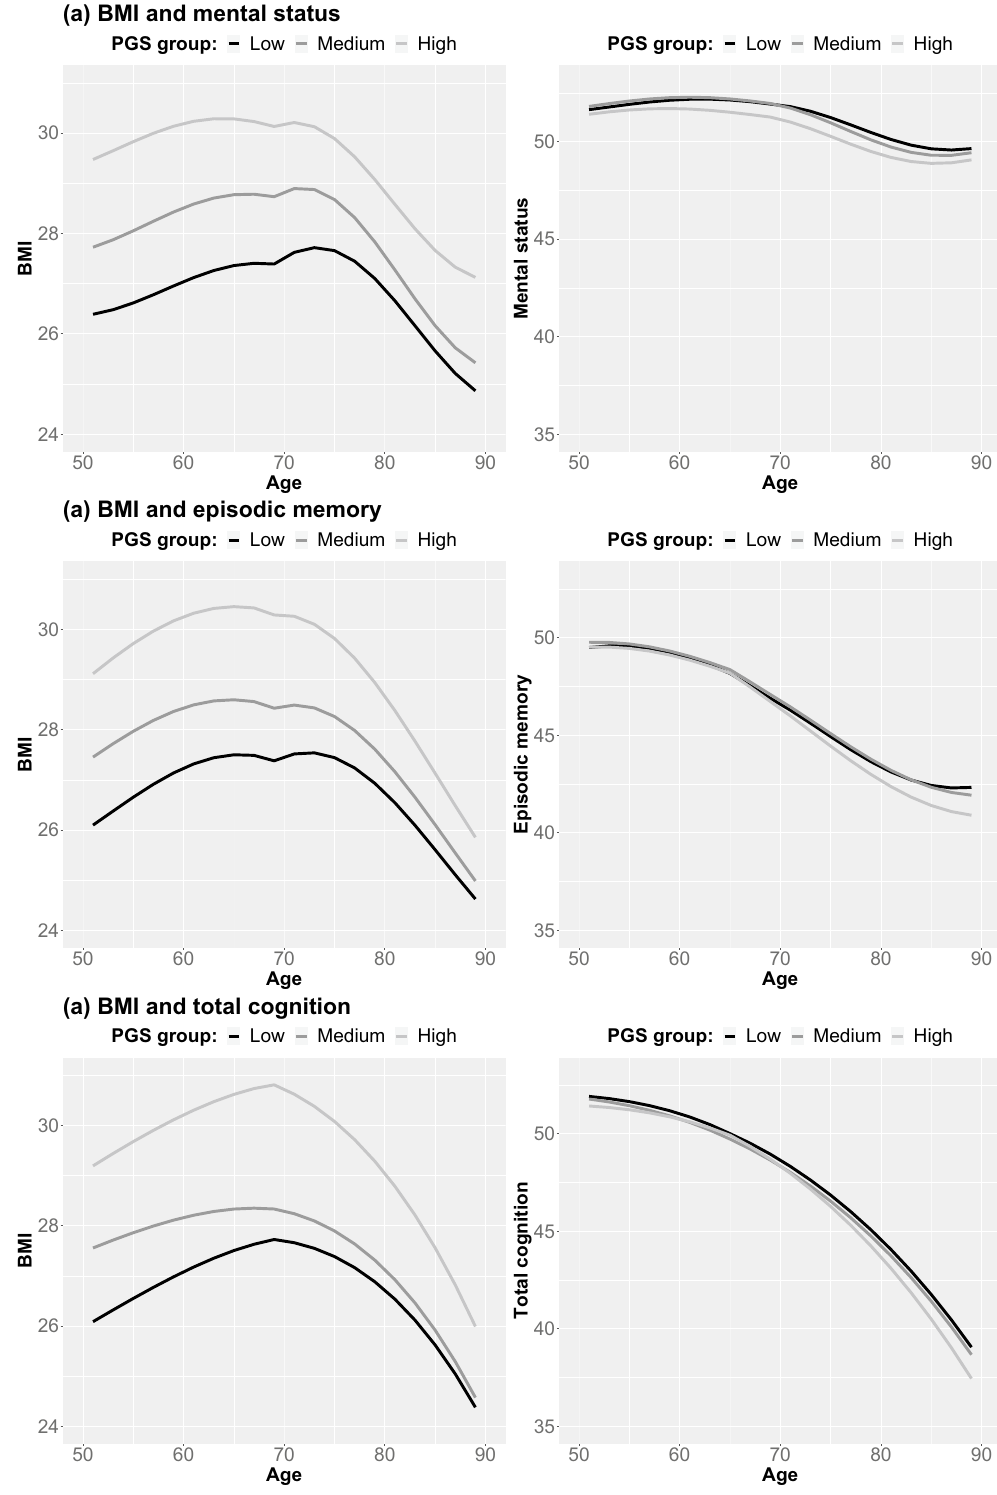
Figure 5. Longitudinal trajectories from bivariate dual change score models, showing change in BMI and cognitive abilities stratified by genetic predisposition to high, medium, or low BMI. All models were adjusted for sex and education, and a breakpoint in the proportional change and coupling parameters was added at age 70 for BMI and mental status, and at 65 for episodic memory and total